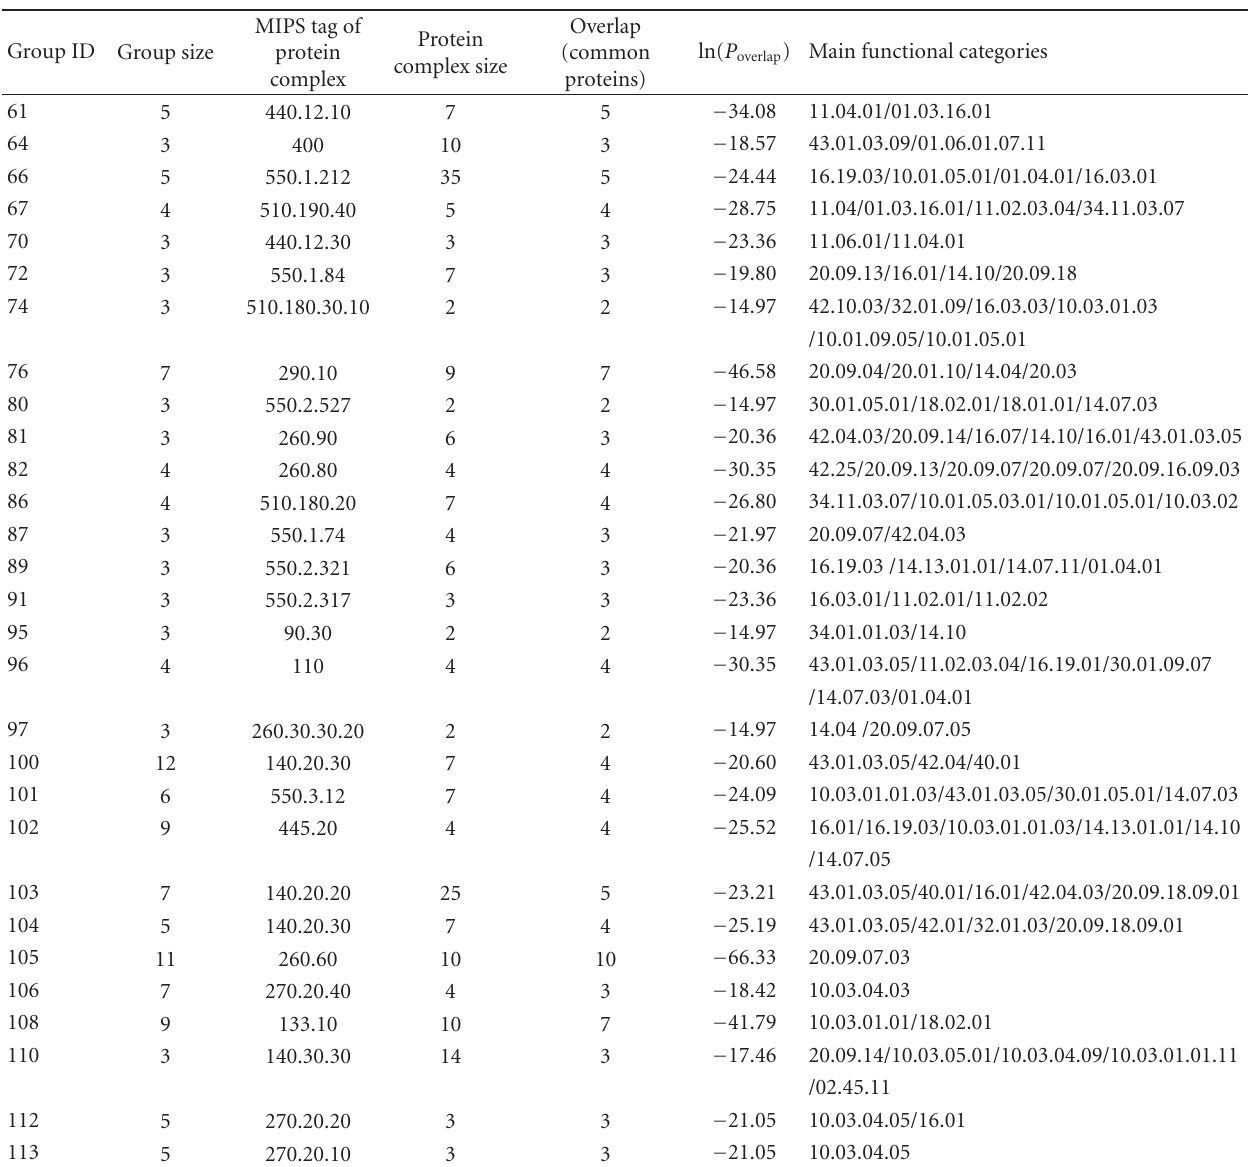
Table 5: Running times of the programs on 3 data sets of yeast